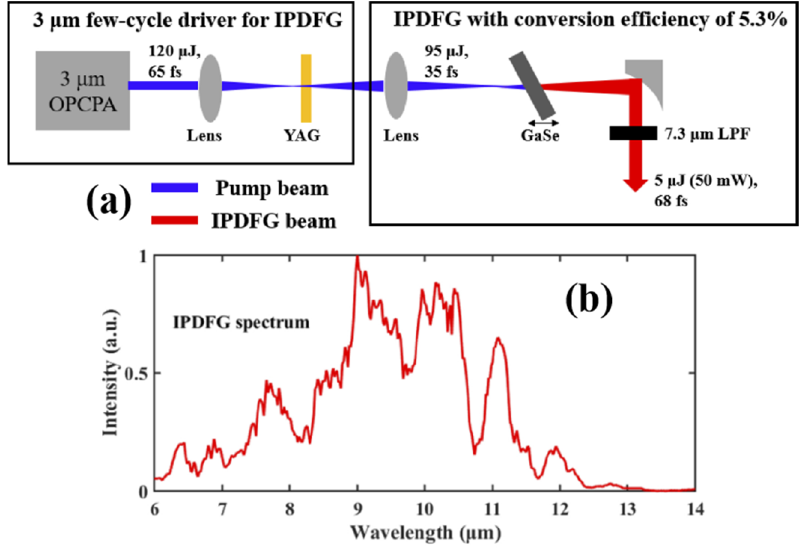
Figure 19. ( a ) The schematic of experimental setups. ( b ) The measured IPDFG spectrum with p-polarization at 5 µ J output energy. Reprinted with permission from [65].